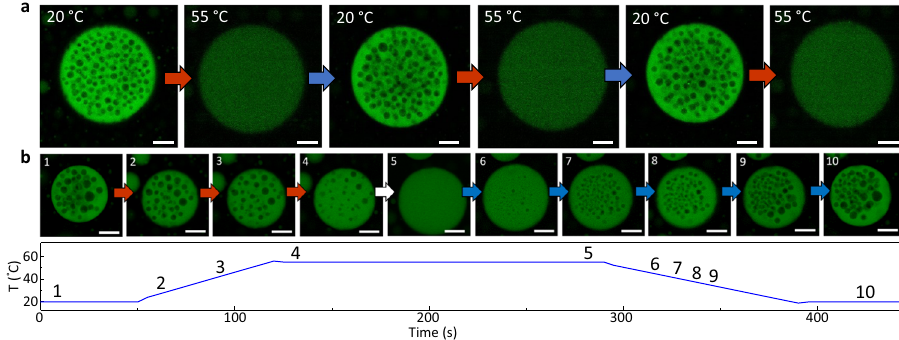
Fig. 1 | Temperature-dependent and reversible trapped droplet formation. a Confocalmicroscopyimagesofmultiplecyclesoftrappeddropletformationand removal (Supplementary Fig. 3). Intensity differences are to show that the con- centration of Poly-rA in the dense phase is higher at 20 than at 55°C